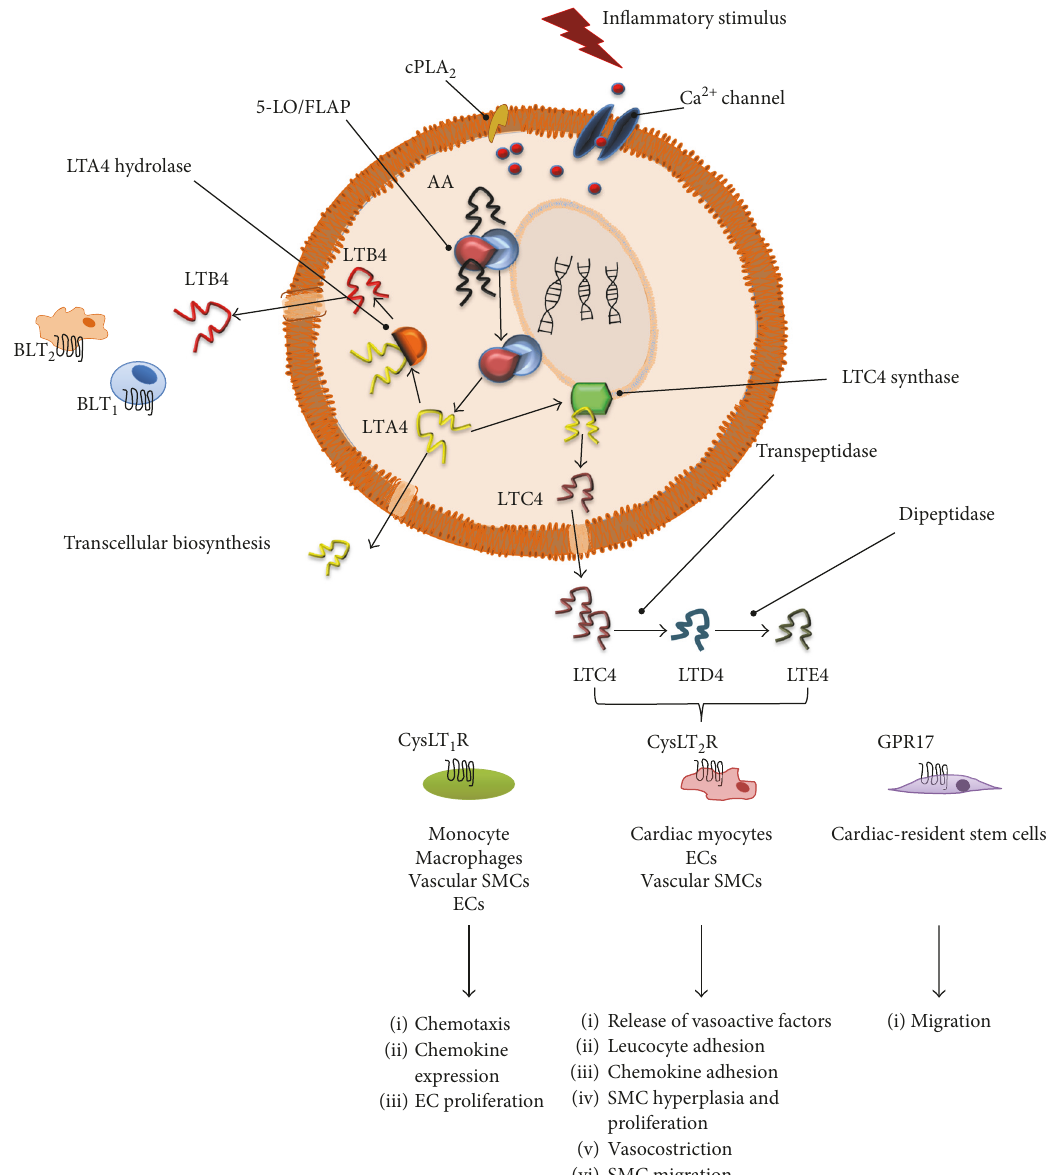
Figure 1: The 5-LO pathway: biosynthesis, signaling, and e ff ect on cardiovascular system. 5-Lipoxygenase (5-LO), leukotriene (LT), cytosolic phospholipase A2 (cPLA ), arachidonic acid (AA), 5-LO-activating protein (FLAP), multidrug resistance protein-1 (MRP1), endothelial cells 2 (ECs), and smooth muscle cells